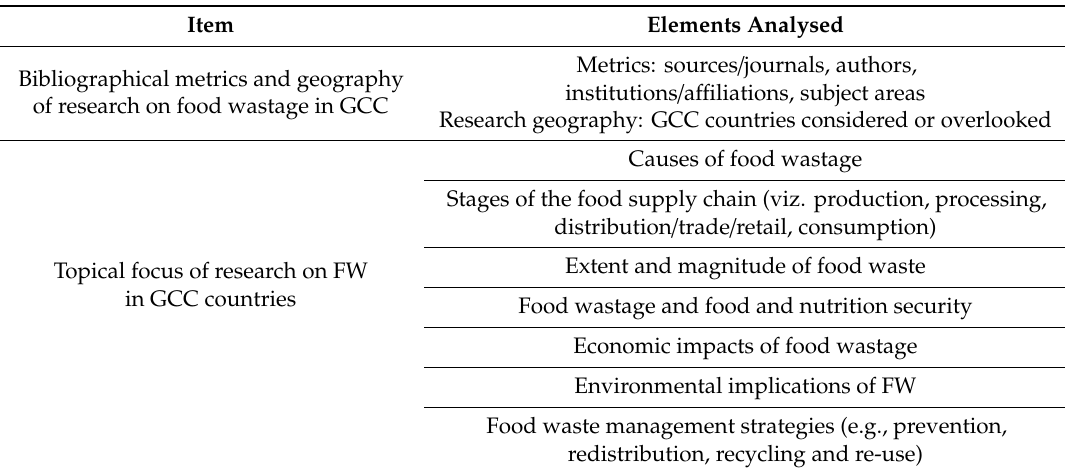
Table 2. Issues and topics analyzed in the systematic